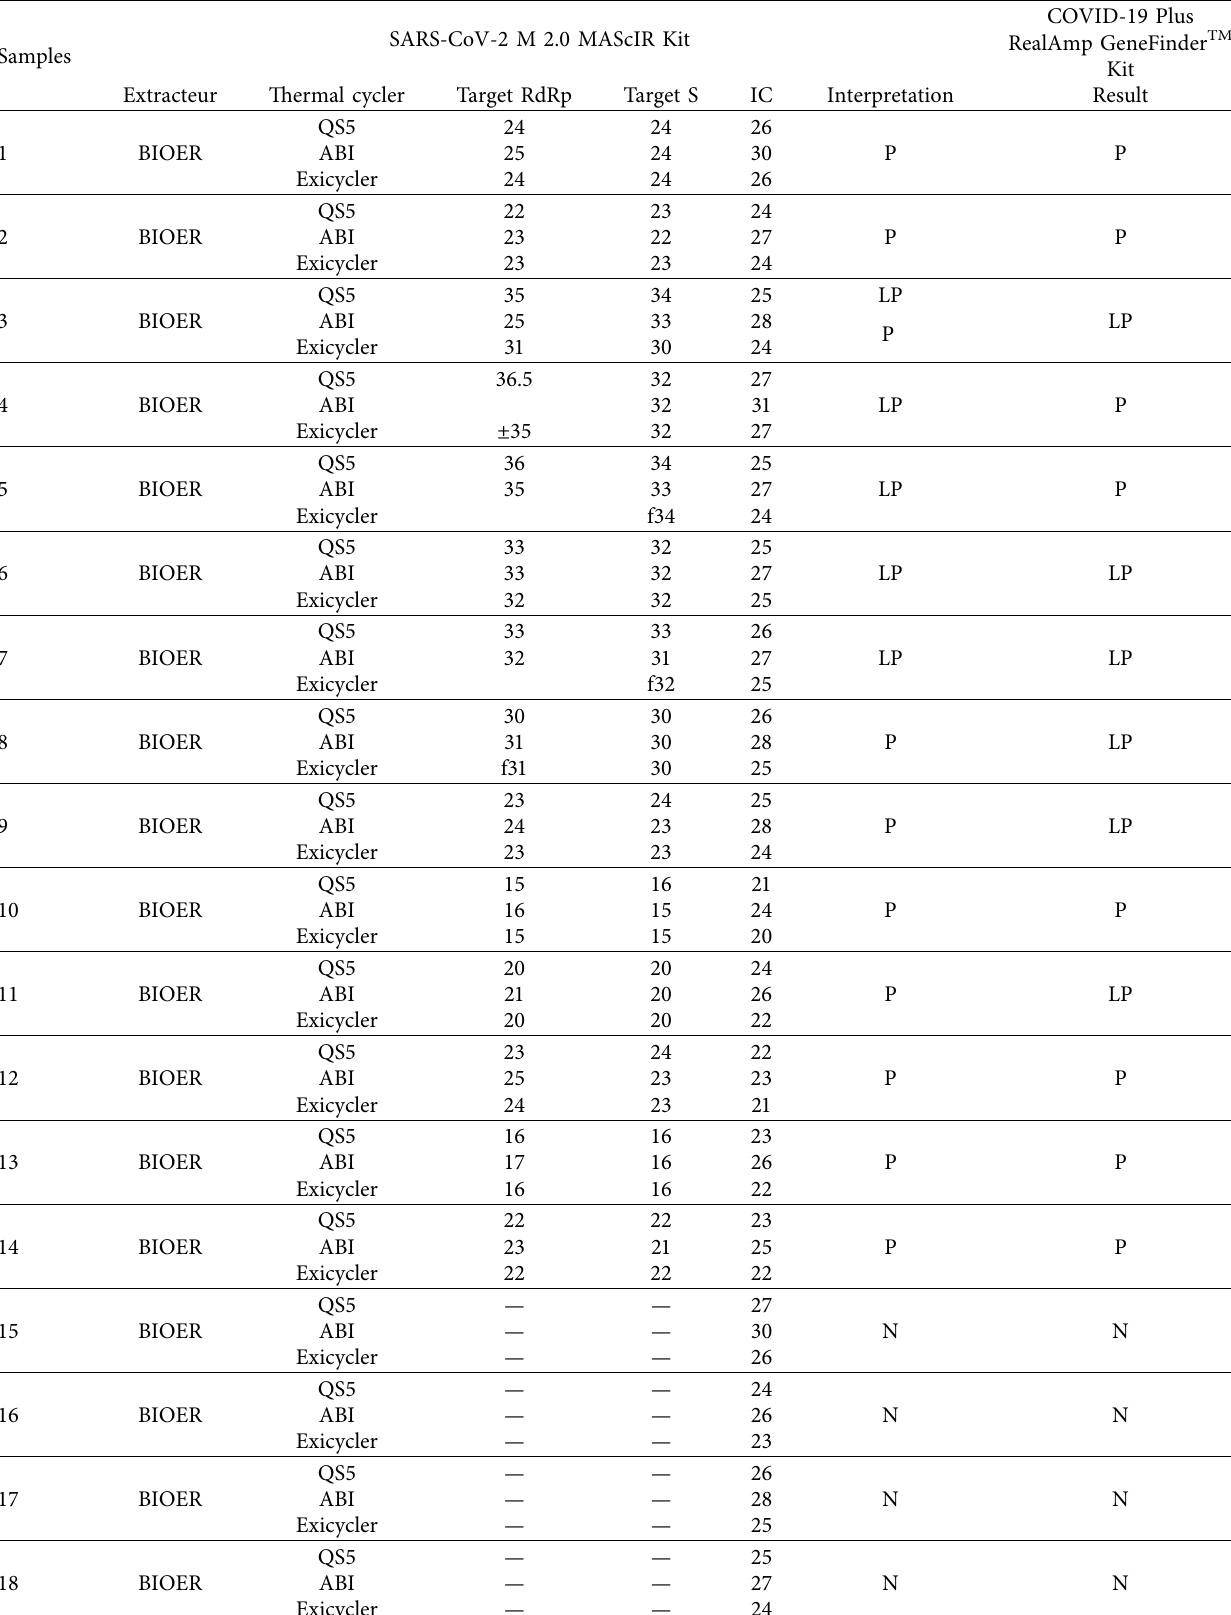
Table 5: Comparison of PCR SARS-CoV-2 results between SARS-CoV-2 M 2.0 MAScIR kit and COVID-19 Plus RealAmp GeneFinder ™ reference